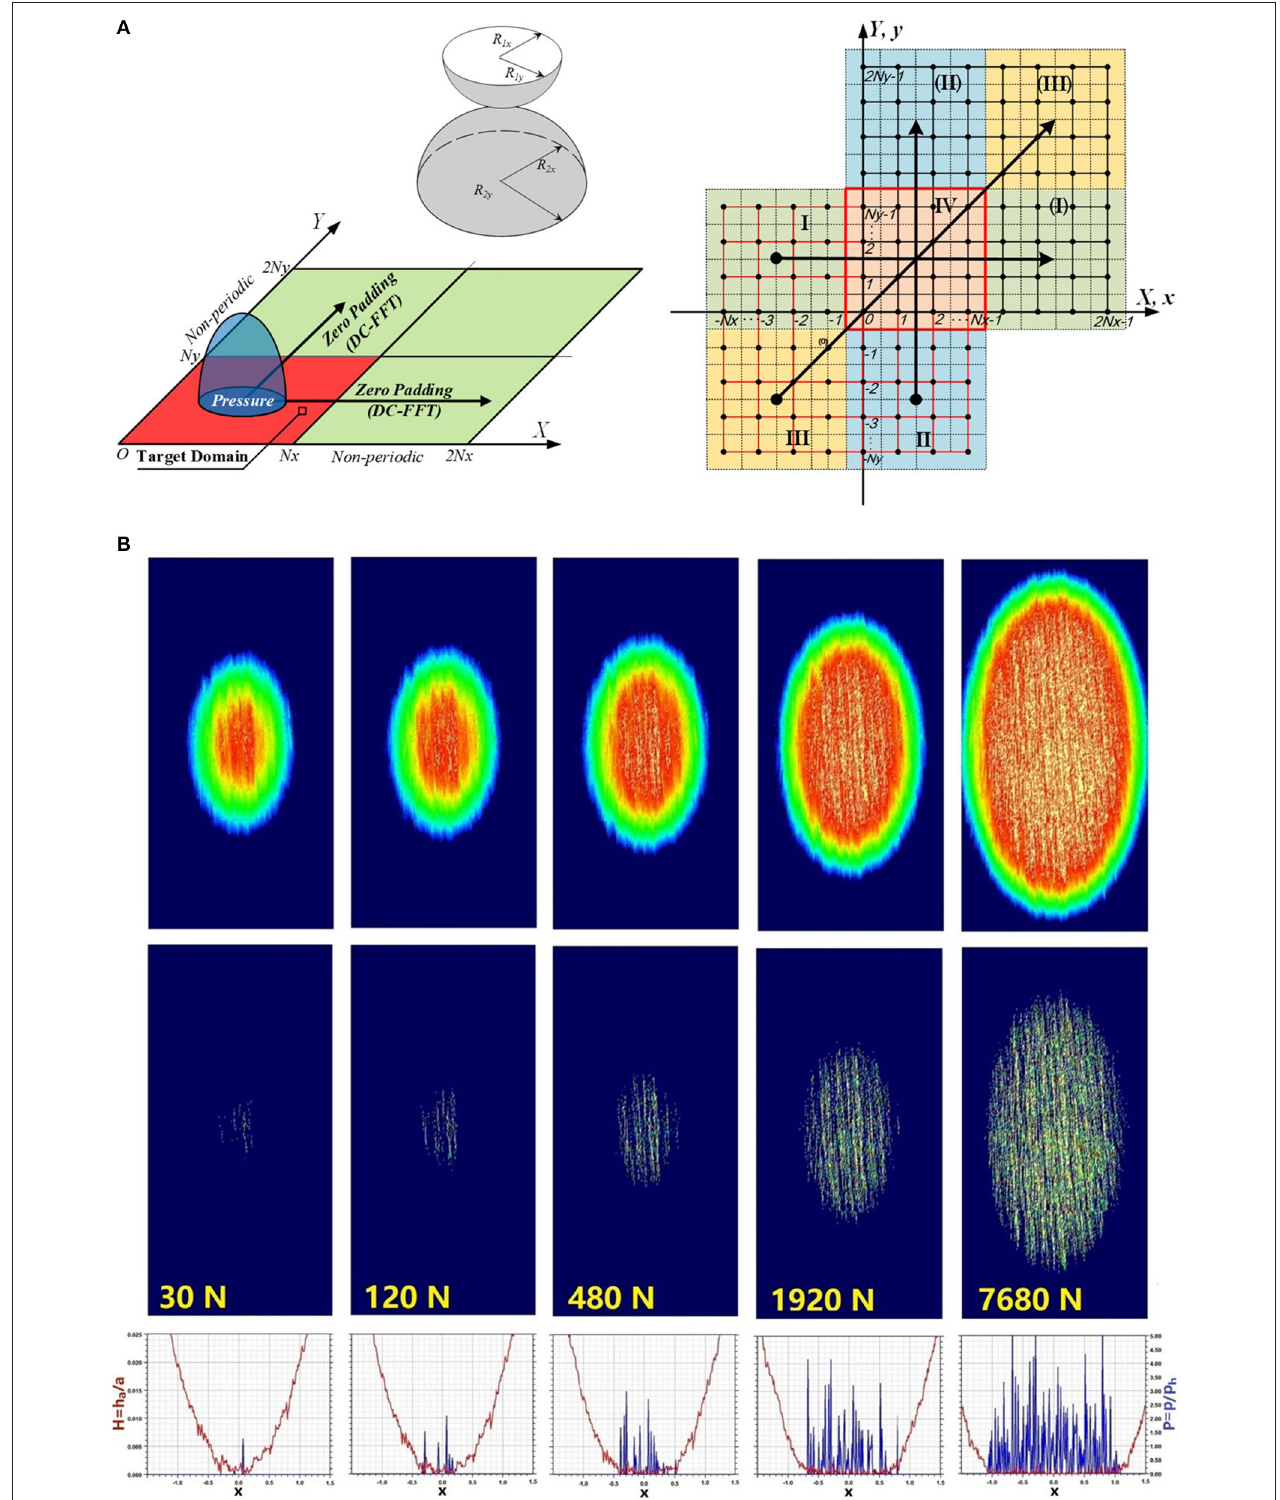
FIGURE 4 | 2D Wrap-around order in both x and y directions and zero padding for 3D point-contact problems (A) , and elliptical contacts of two rough surfaces under different normal loads (B) . In (A) , the arrows show the directions of the IC wrap-around order. In (B) , the light-colored patterns inside the blue (middle) and red (top) contours show asperity contact pressure and